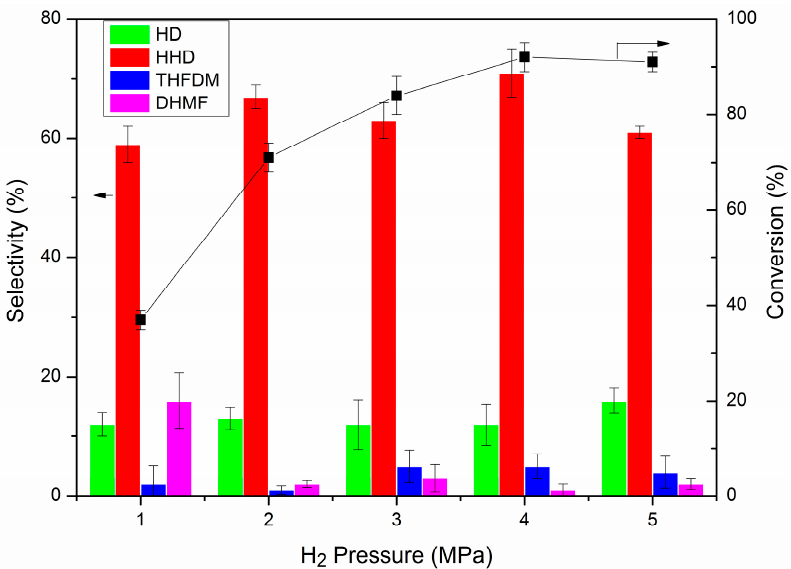
Figure 1. The effect of H 2 pressure on the hydrogenation of HMF. Reaction conditions: Pd/C (5.0 mg, mole ratio, HMF/Pd = 420:1), HMF (1 mmol), AcOH (60.0 mg, 1 mmol), H 2 O (2.00 g), H 2 (1–5 MPa), 393 K, 1 h. The error bars refer to the confidence interval with 95% confidence.